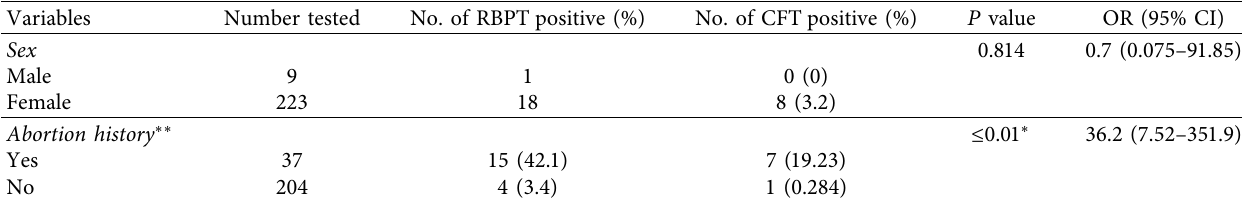
Table 1: Overall Brucella seroprevalence and association of abortion with the disease in camel. Variables